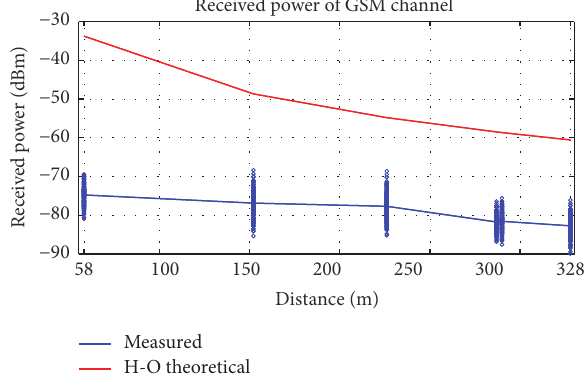
Figure 2: Measurement spots in north Bogot´a, Colombia.